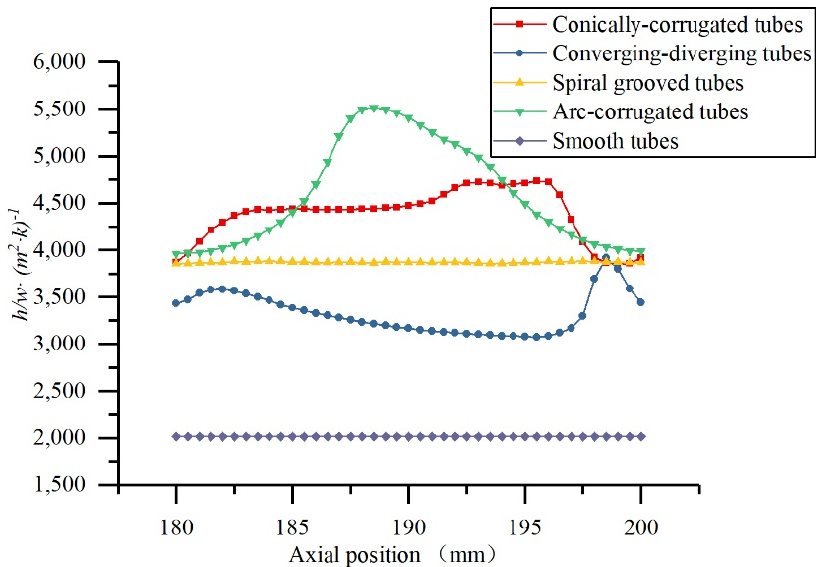
Figure 11. The local heat transfer coefficient plotted at each plane at Re = 10,000 for HEHE tubes.